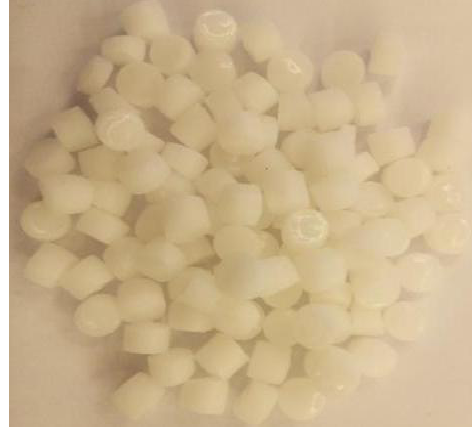
Figure 6. The macro morphology of TOR.